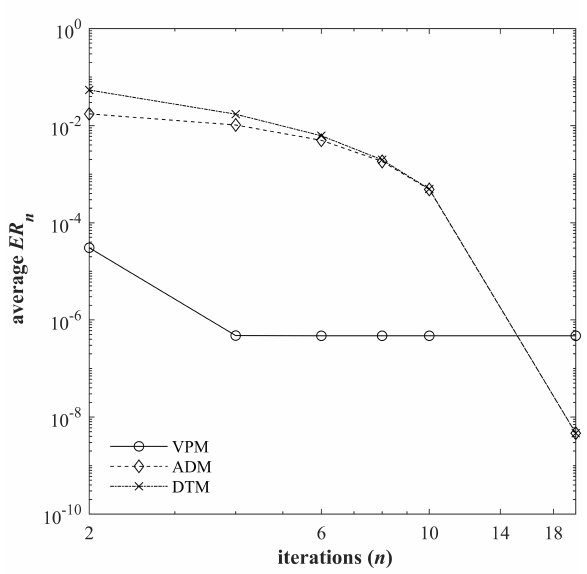
Fig. 5: Comparison of the average error remainder as a function of iteration for the approximate solutions of equation (33) using VPM, ADM, and